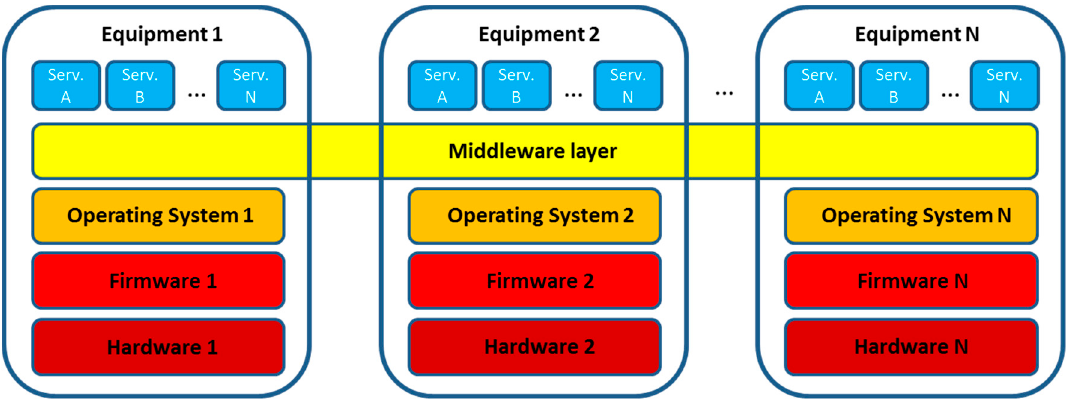
Figure 1. Existing middleware architecture among hardware devices.